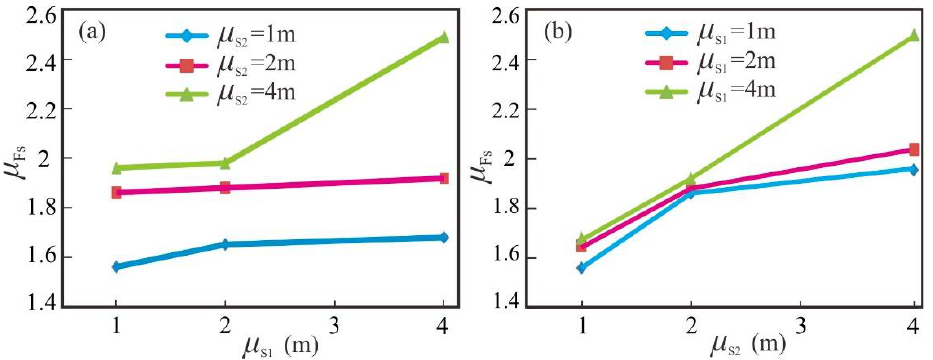
 with  increases; b-the increases; ( b )—the Fs 1 1 S